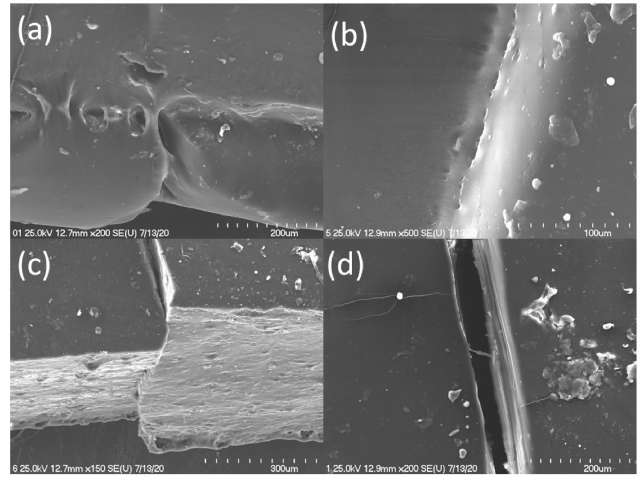
Figure 9. Picture of healed part of material observed in pure ENR ( a ), ENR/quercetin4 ( b ), ENR/quercetin4/silica15 ( c ) and ENR/DCP2 ( d